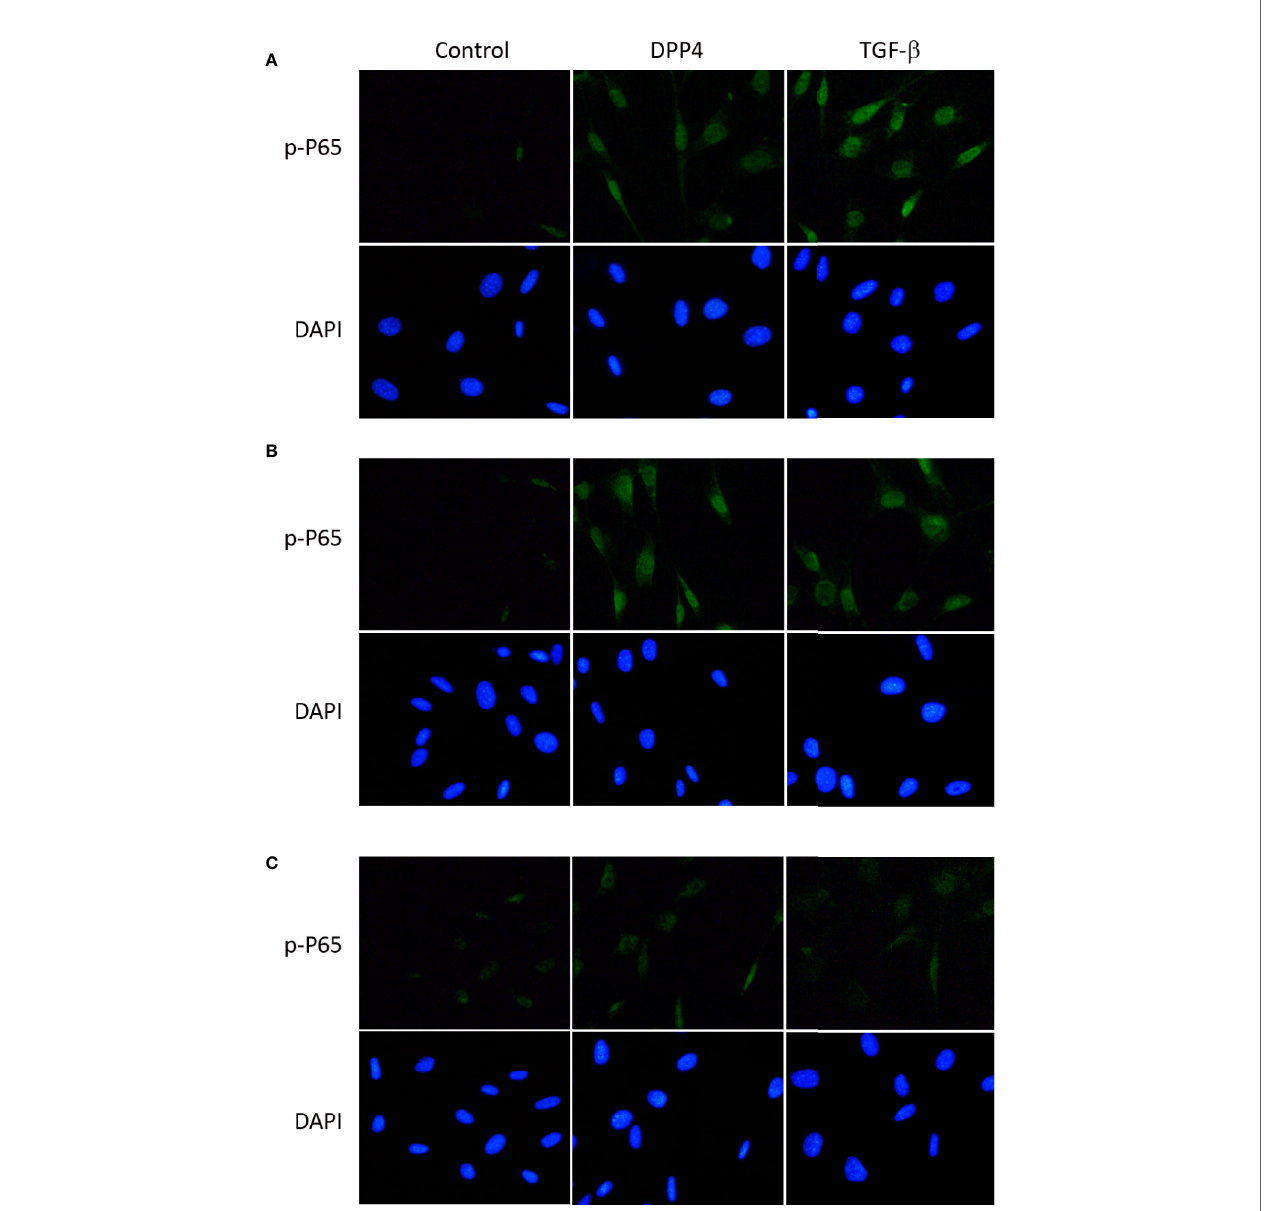
FIGURE 5 | Effects of DPP4 on p-p65 activation in human dermal fi broblast. Human dermal fi broblast were treated with recombinant DPP4 (200 ng/mL) or TGF- b (10ng/mL). Immuno fl uorescent staining of p-p65 was determined after (A) 6 h, (B) 24 h, and (C) 48 h of DPP4 or TGF- b